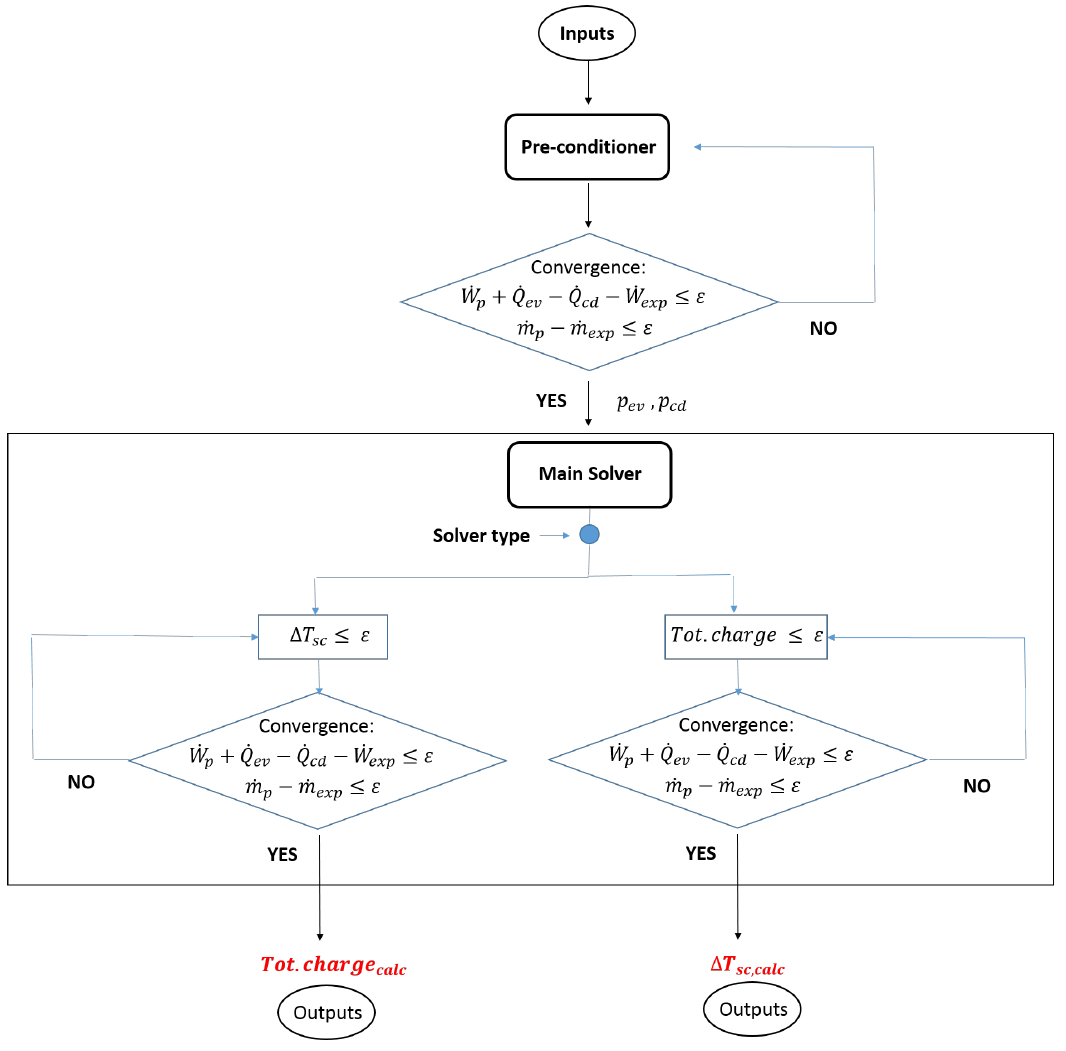
Figure 6. Solution scheme of the overall ORC